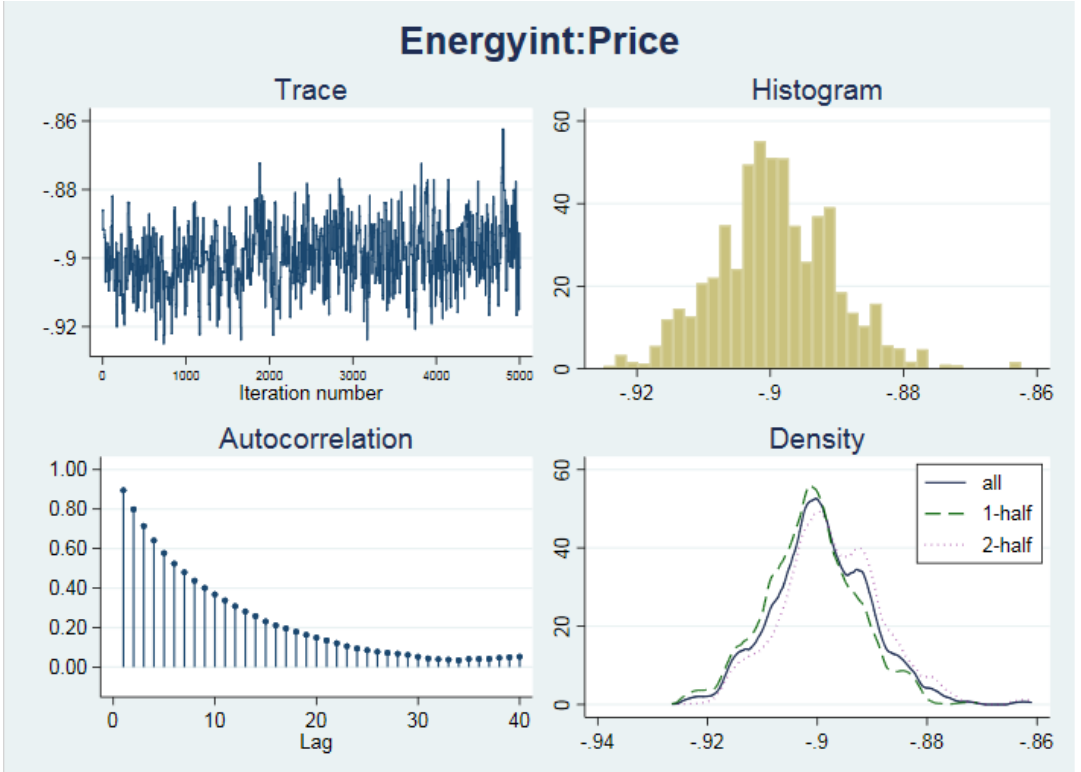
Figure 5. Multiple posterior density simulated by MCMC for logarithm of energy price